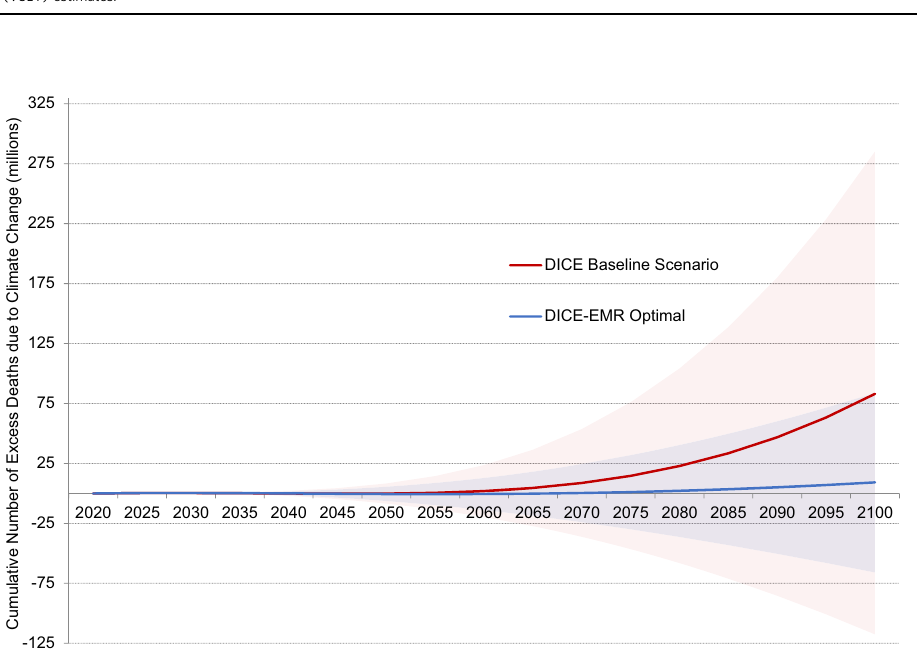
Fig. 3 Cumulative number of excess deaths from climate change in DICE-EMR. The DICE baseline emissions scenario results in 83 million cumulative excess deaths by 2100 in the central estimate. Seventy-four million of these deaths can be averted by pursuing the DICE-EMR optimal emissions path, which results in 2.4 °C of warming and nine million deaths by the end of the century. The red shaded region shows the range between the high (>90th percentile) and low (<10th percentile) projections for excess deaths in the DICE baseline emissions scenario. The blue shaded region shows the range between high and low projections for excess deaths in the DICE-EMR optimal emissions path.